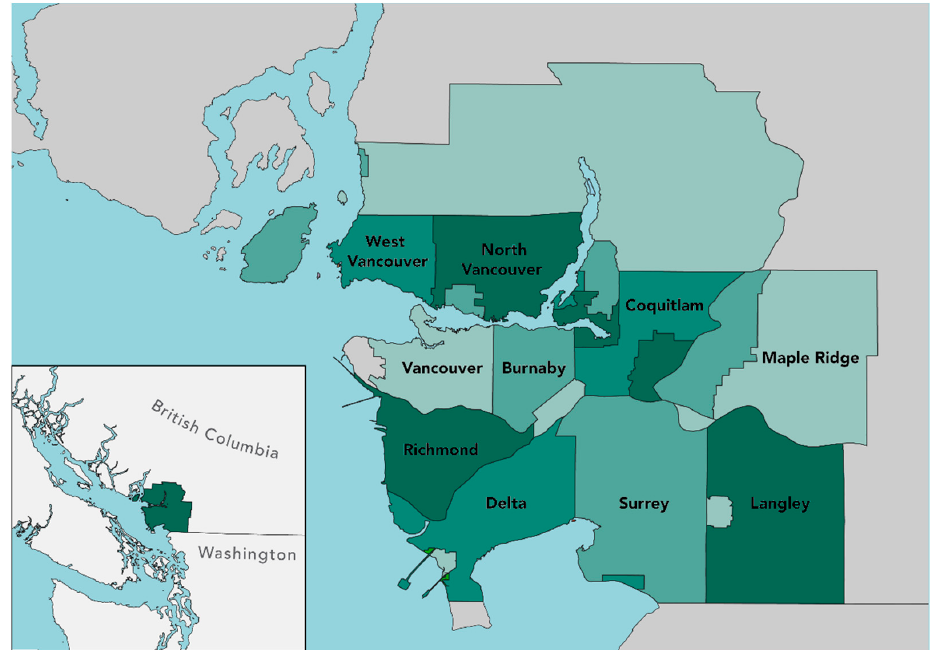
Figure 1. Map of study area in the context of the Pacific Northwest. The Tsawwassen First Nation Treaty, 21 municipalities, and one Electoral Area form the region known as Metro Vancouver.